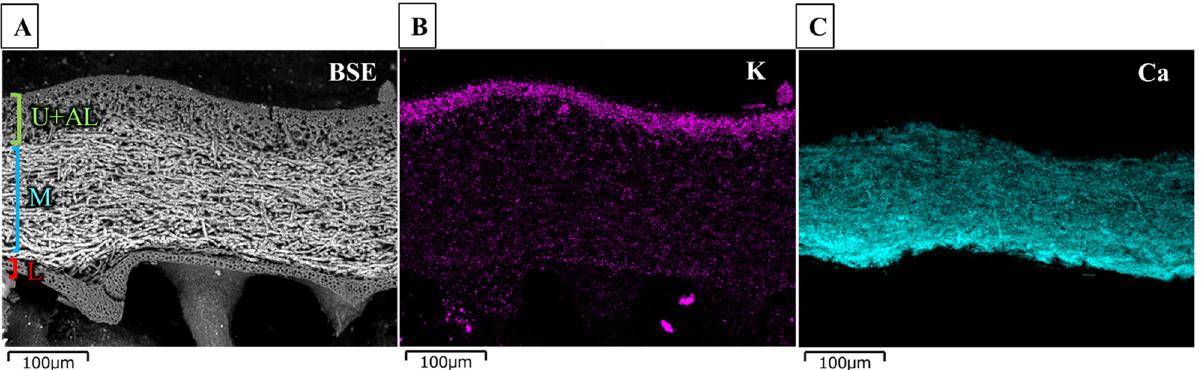
Fig 10. Microscopic image and elemental analysis of the FY2012PT thallus cross-section. The sample was analysed without any coating by SE-SEM with EDS. (A) Cross-sectional backscattered electron (BSE) image. U+AL, upper cortex including the algal layer; M, medullary layer; L, lower cortex. The M-layer appears white in the BSE image because it contains elements with higher atomic numbers than the surrounding elements. (B) Potassium and (C) calcium distributions were observed by EDS.